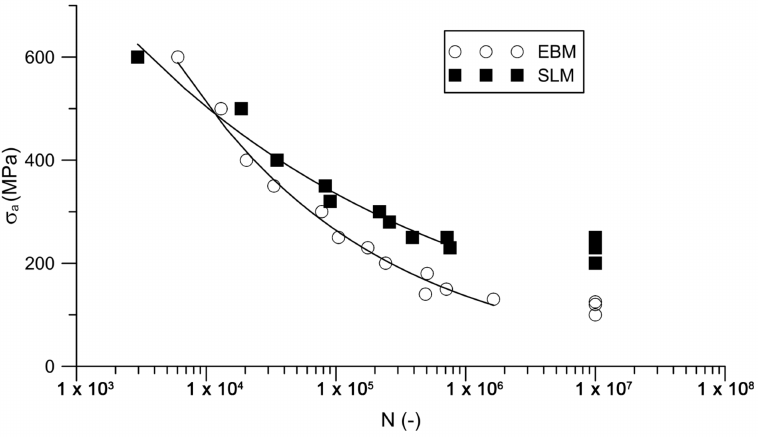
Figure 6. S-N curves of SLM and EBM